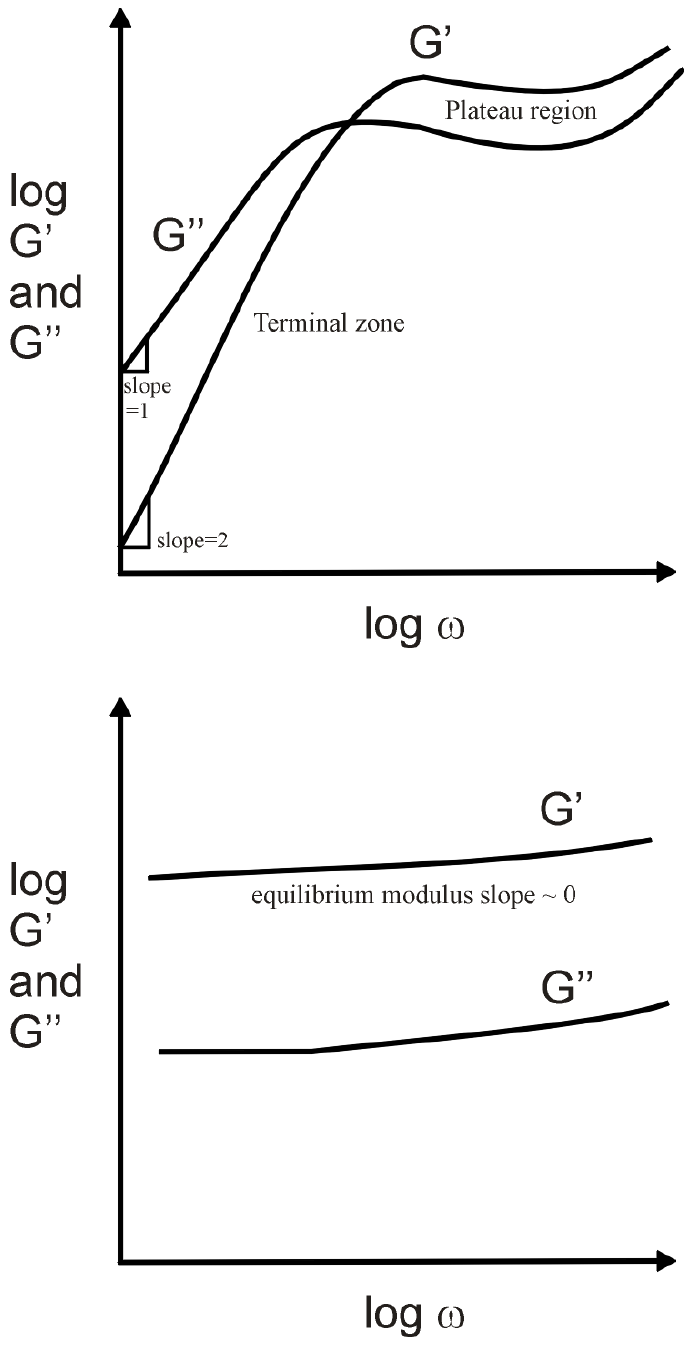
FIGURE 5. Mechanical spectra for an entanglement network (top) and a gel system (bottom). low frequencies, in the 'terminal zone' they flow as high viscosity liquids. Gel systems generally show no entanglement effects, and G ′ and G ″ are parallel, with G ′ > G ″ and largely frequency insensitive i.e. G ′ and G ″ ≈ ω 0